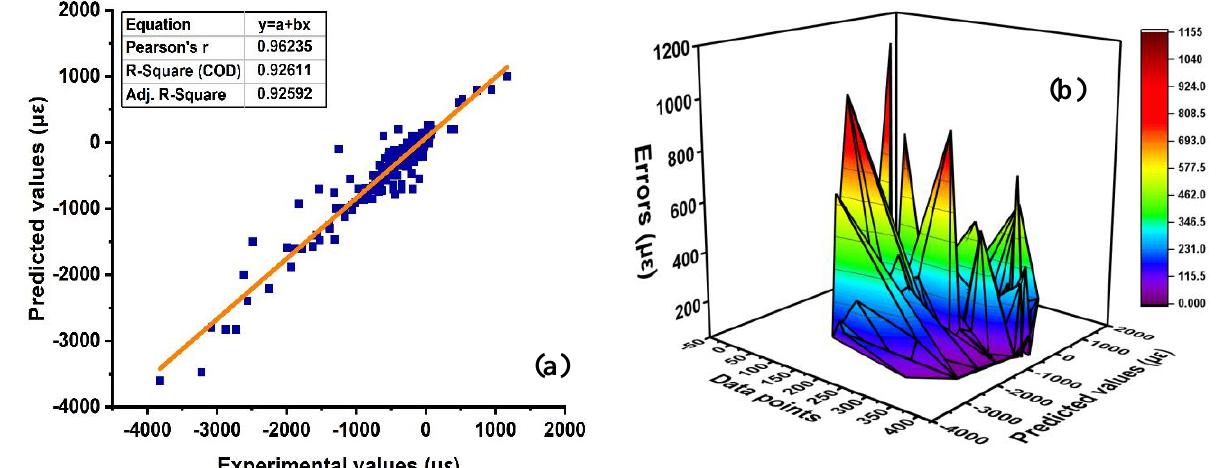
Figure 6. SVM ensemble model; ( a ) SVM with bagging; ( b ) Error distribution of SVM bagging. Table 4. Statistical analysis of the SVM model with